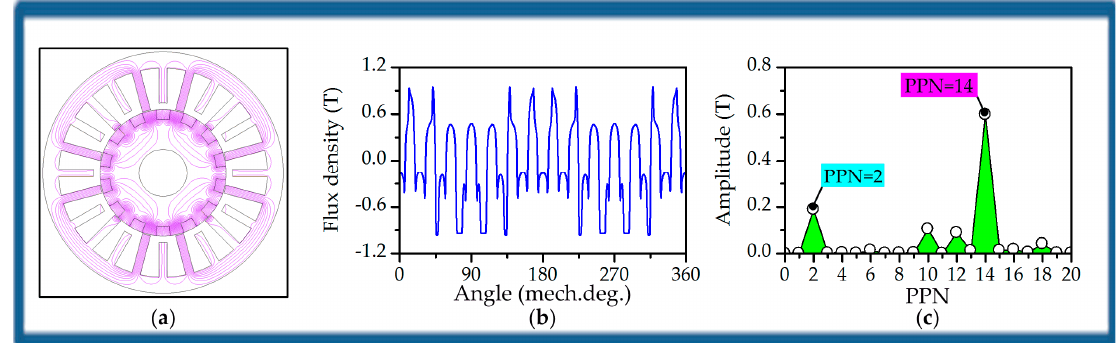
Figure 7. Analysis of magnetic field excited only by rotor PMs: ( a ) Flux lines distribution; ( b ) Flux density in the air-gap; and, ( c ) Harmonic spectrum.